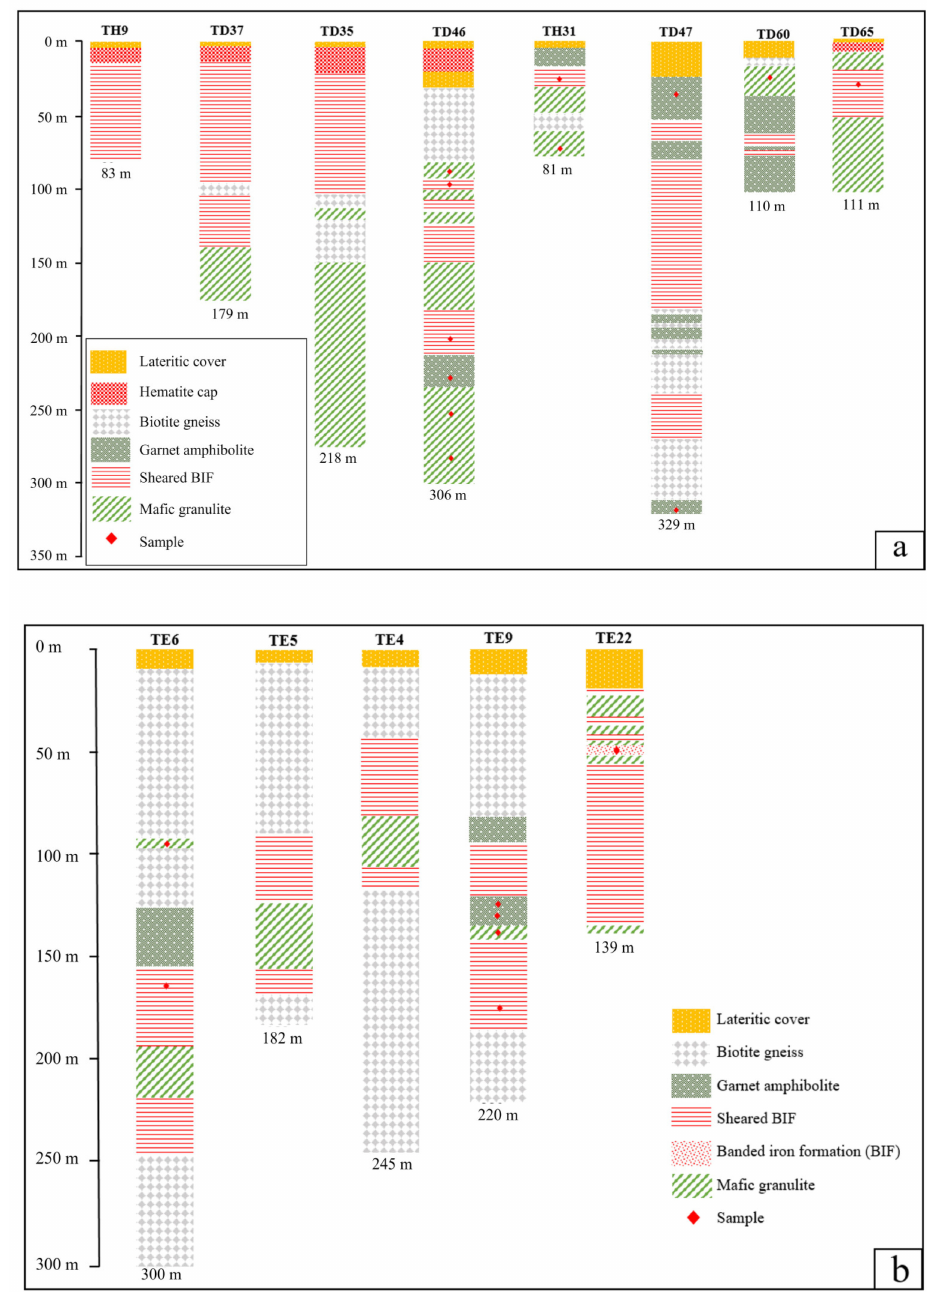
Figure 4. Stratigraphic logs with sample locations at the Anyouzok ( a ) northern prospect and ( b ) southern